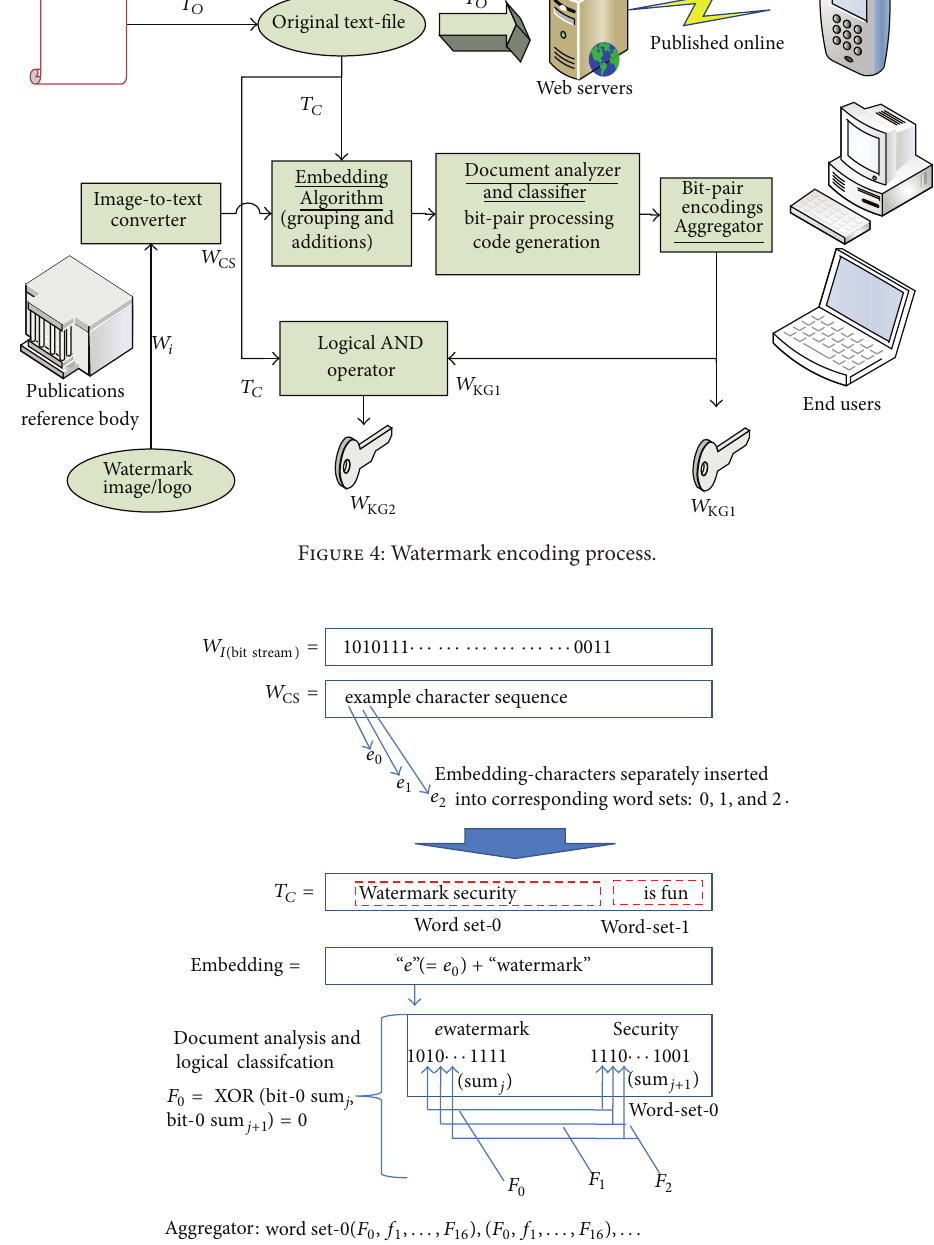
Figure 5: Partial function code generated in the